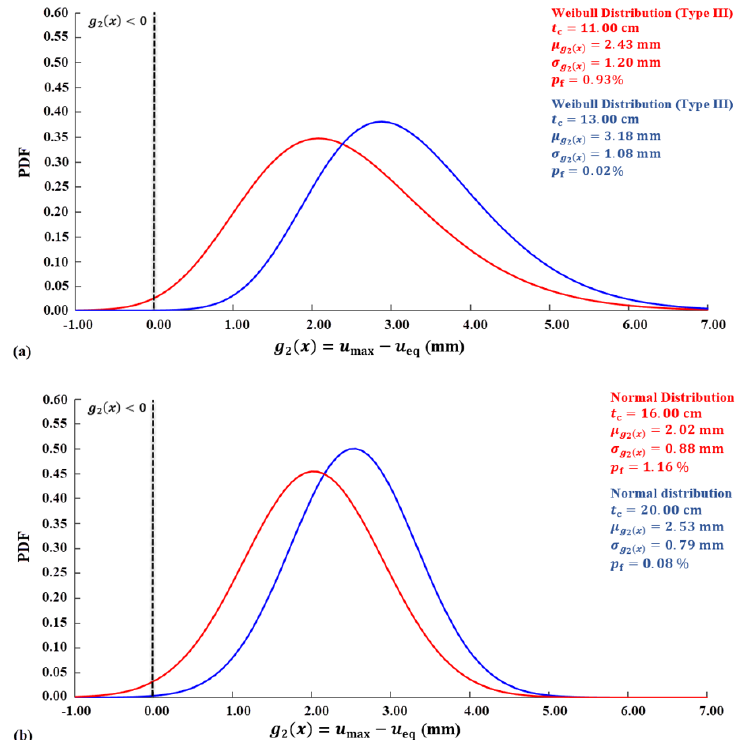
Figure 11. Histograms of performance